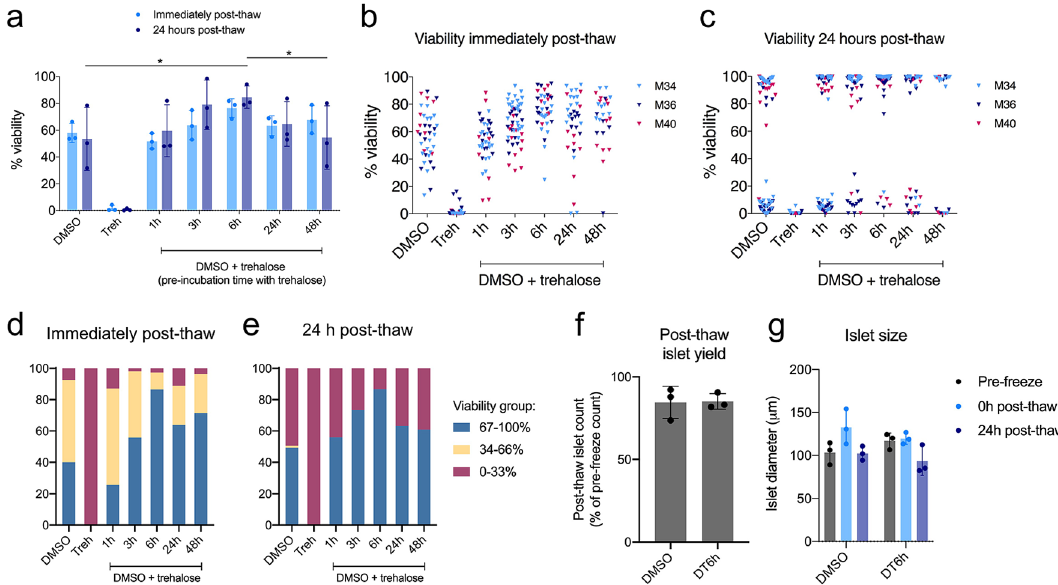
Figure 4. Viability, size and number recovered using the proposed islet cryopreservation protocol. ( a ) Post- thaw viability of pancreatic islets cryopreserved with proposed DMSO + trehalose protocol with varying trehalose pre-incubation time (1–48 h). Viability measured immediately post-thaw (light blue bars) and 24 h post-thaw (dark blue bars) shown. Bars represent mean ± SD, n = 3 islet isolations, repeated measures two-way repeated measures ANOVA followed by Tukey’s HSD post-hoc test, all groups were significantly different from trehalose only (Treh), other significant differences (p ≤ 0.05) are marked by asterisks. ( b ) Post-thaw viability of individual islets from the experiments shown in ( a ) measured immediately post-thaw and ( c ) 24 h post- thaw. Triangles represent individual islet viabilities; triangles of same colour represent results from the same experiment. ( d ) Distribution of islets from ( a ) in three viability groups for DMSO- and DT6h-cryopreserved islets immediately post-thaw and ( e ) 24 h post-thaw. ( f ) Post-thaw islet yield for islets cryopreserved with DMSO or DT6h, calculated as number of islets recovered after thawing/number of islets before freezing. ( g ) Average islet diameter of DMSO- and DT6h-cryopreserved islets measured pre-freeze, 0 h post-thaw and 24 h post-thaw. All figures were produced using GraphPad Prism (version 8.4.1, https:// www. graph pad. com). DT6h DMSO + trehalose pre-incubated for 6 h, Treh trehalose